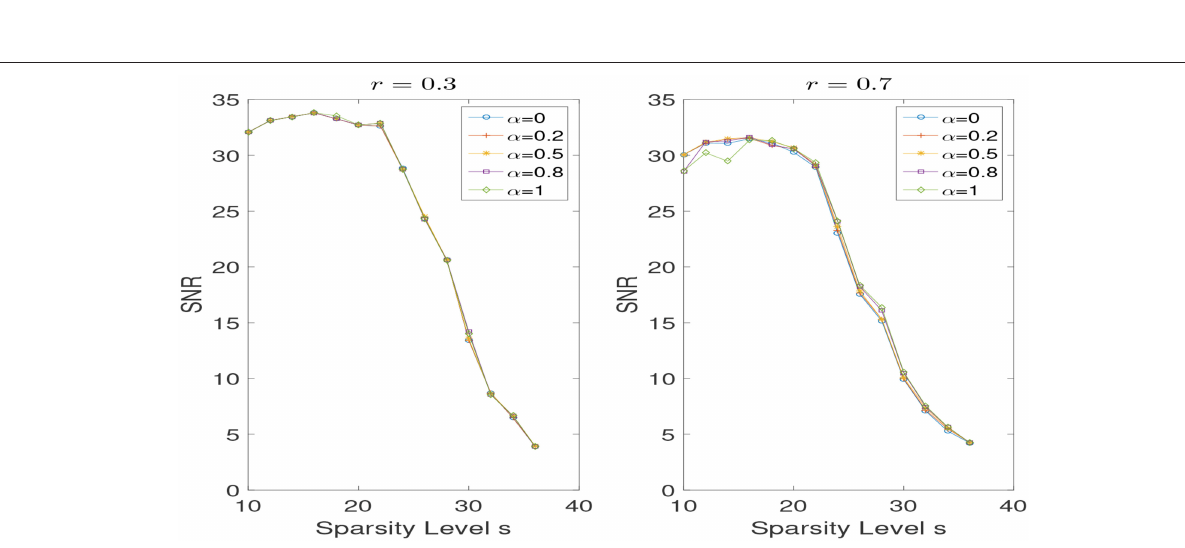
FIGURE 4 | SNR for different α with r